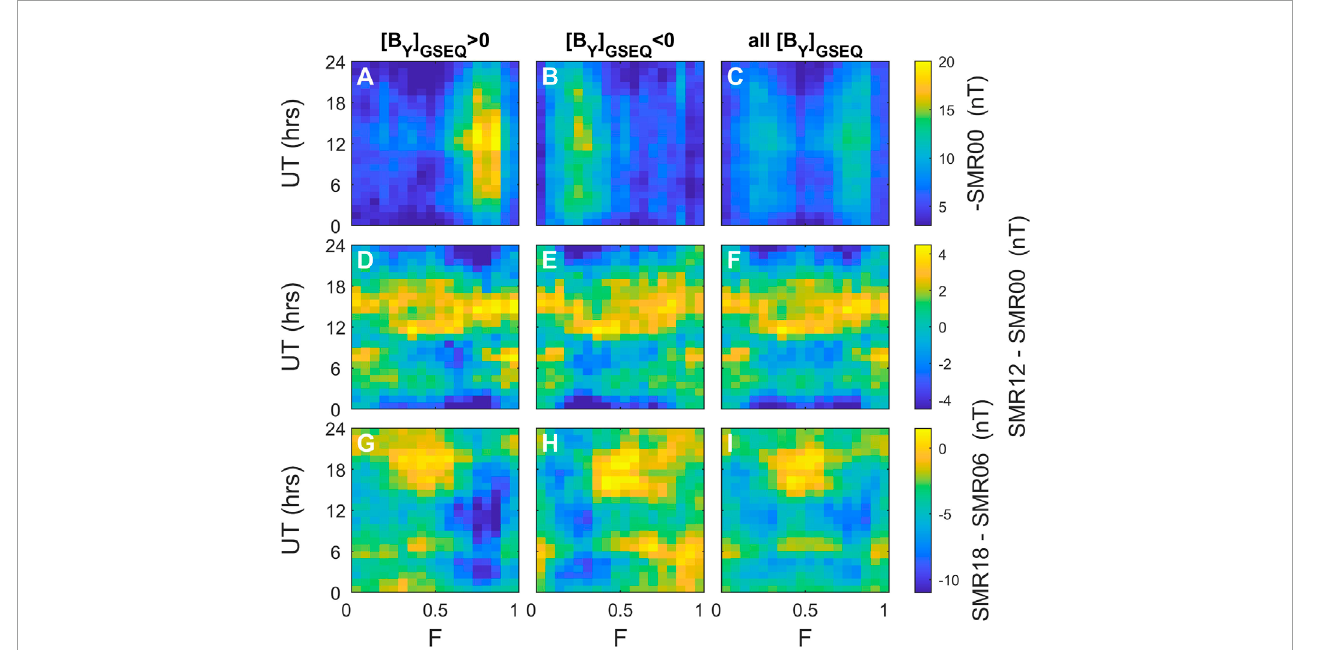
FIGURE 19 F-UT variations of selected SuperMAG partial ring current indices described by Newell and Gjerloev (2012). The top row is for -SMR00 , the middle row for SMR12-SMR00 and the bottom row for SMR18-SMR06 . The left-hand column is for [ B Y ] GSEQ > 0, the middle column for [ B Y ] GSEQ < 0 and the right-hand column for all [ B Y ] GSEQ . Data are for 1980–2021,